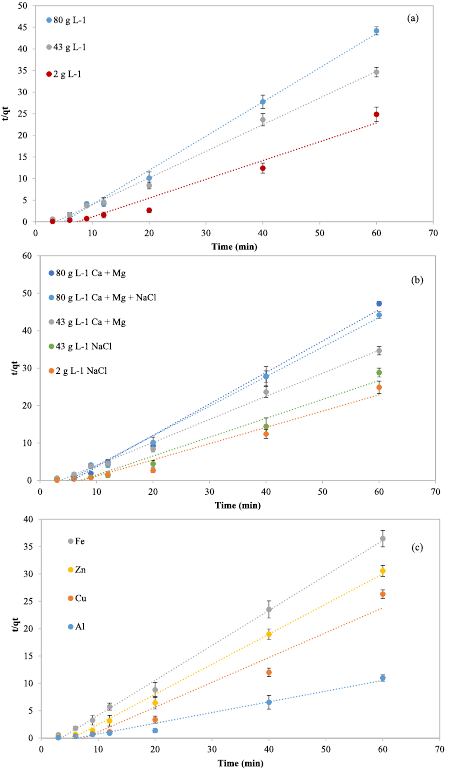
Fig. 5 Pseudo-second order adsorption kinetics at various conditions. a Effect of the salt content; b effect of the nature of the salinity; c effect of the electrode material. (Experimental conditions: pH 7, current density 25 mA cm − 2 , salinity 43.5 g L − 1 ). Error bars represent standard